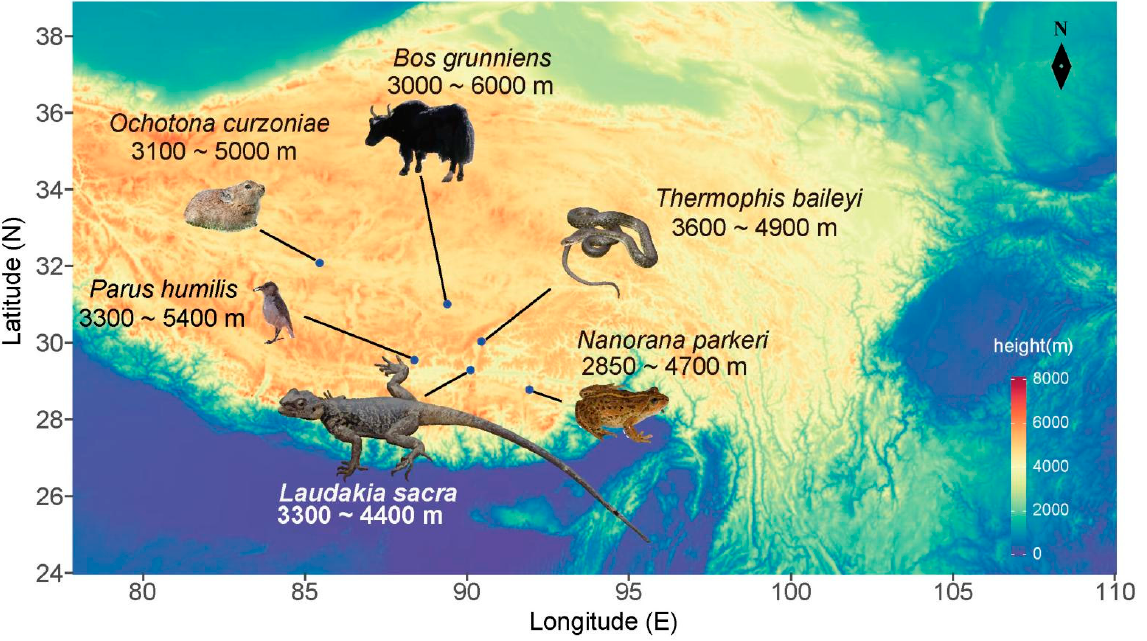
Figure 1. Plateau species included in the study, with habitat elevation listed below each species.